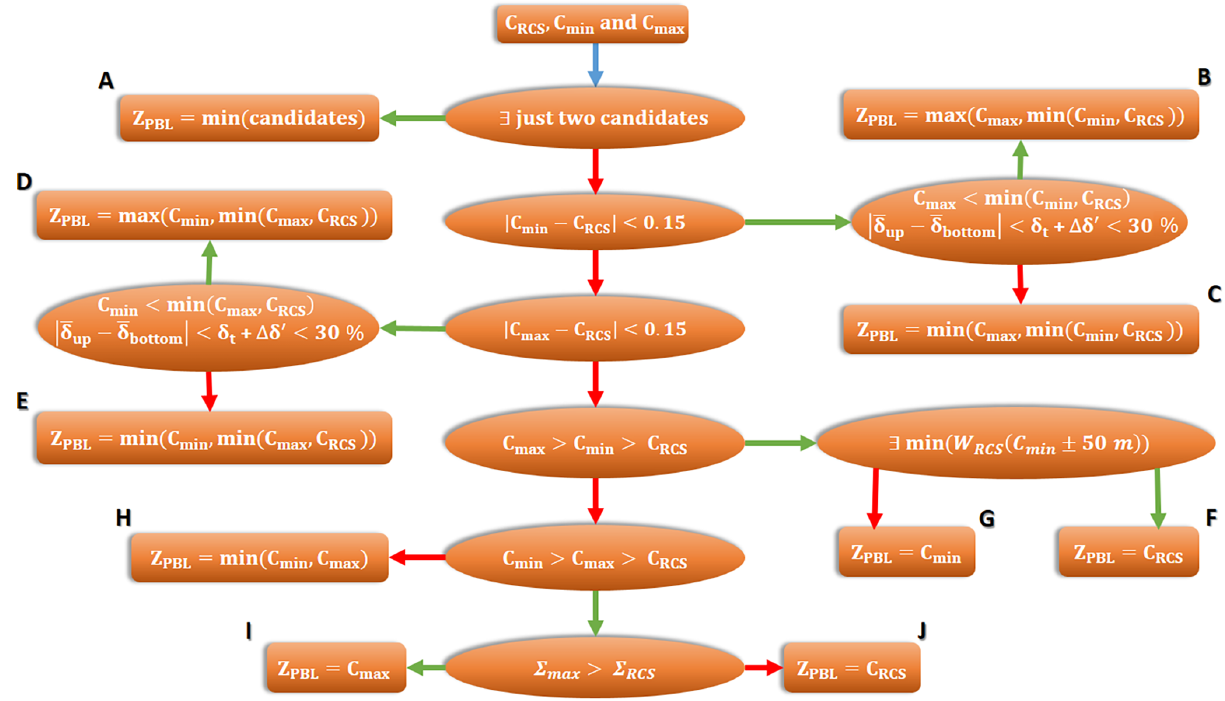
Figure 3. Flux diagram of the algorithm used by POLARIS to determine the z PBL . C min , C max and C RCS are the candidates. The blue arrow indicates the start. Conditions are marked in ellipses and the final attribution of the z PBL in rectangles. The green and red arrows indicate the compliance and noncompliance of the conditions, respectively. The rest of the symbols are explained in the text.